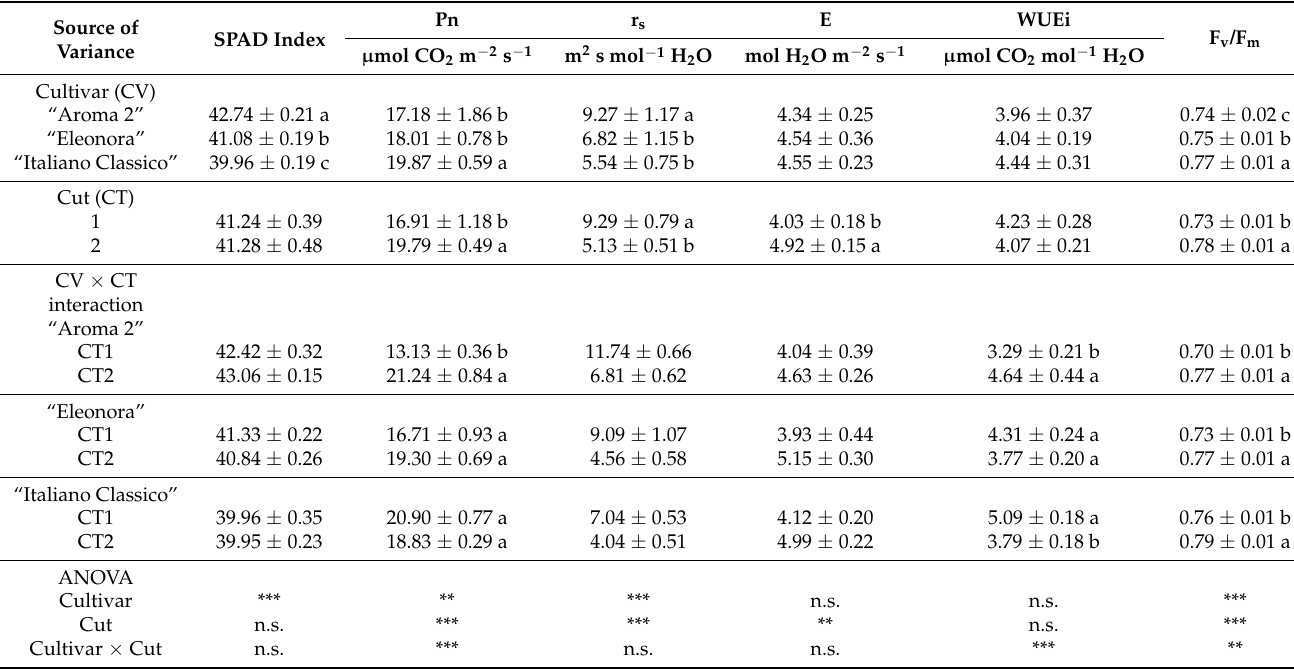
Table 3. Effect of cultivar and cut on leaf chlorophyll index (SPAD), net photosynthesis (Pn), stomatal resistance (r s ), transpiration (E), intrinsic water use efficiency (WUEi), and maximum chlorophyll fluorescence ratio (F v /F m ).